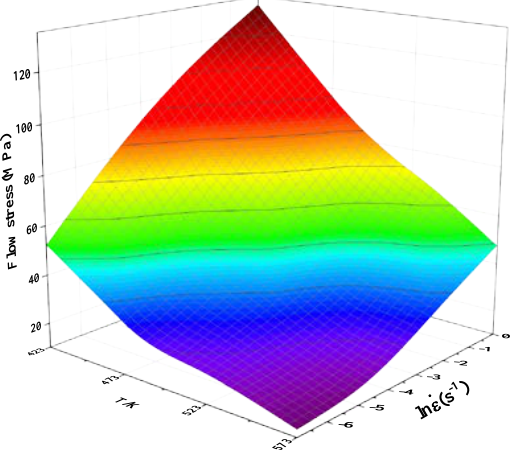
Figure 4. Representation of flow stress as a function of temperature and strain rate at strain of 0.3.